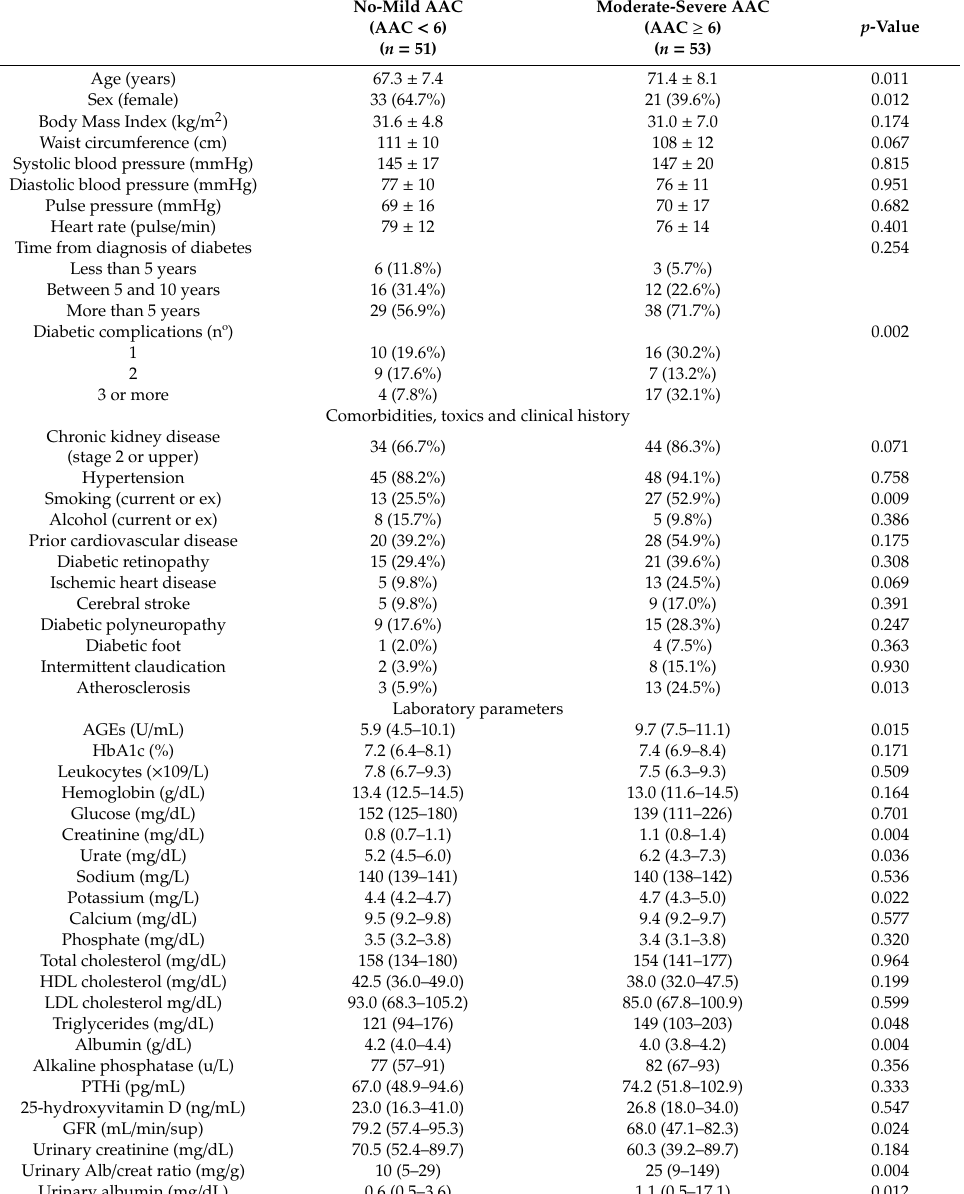
Table 3. Clinical characteristics and laboratory parameters between patients with no-mild AAC and moderate–severe